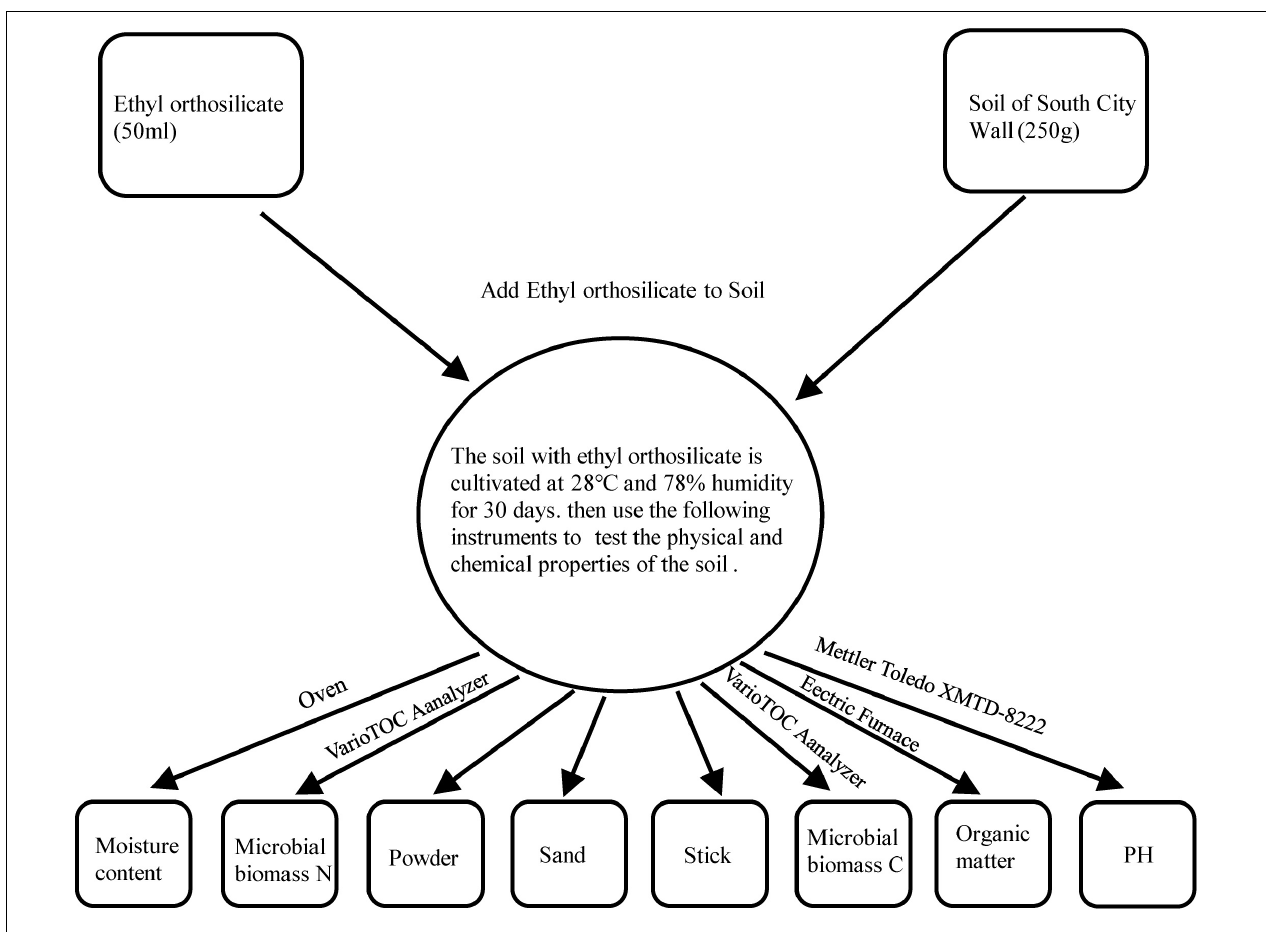
FIGURE 3 | Flow chart of Soil analysis using protective